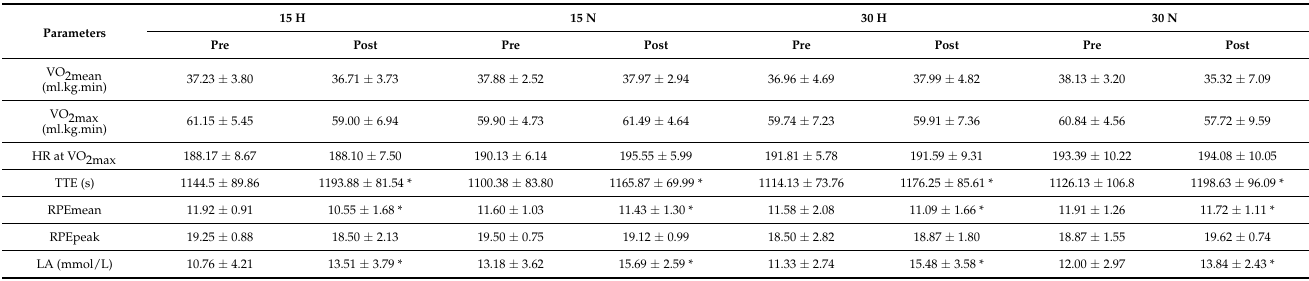
Table 2. Maximal oxygen consumption test values with related